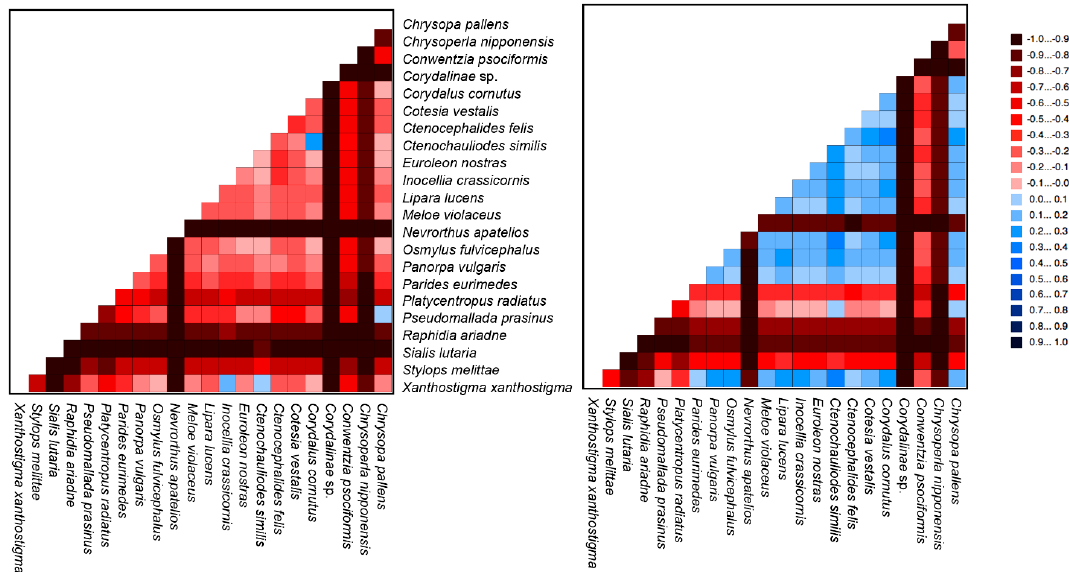
Figure 5. AliGROOVE analysis for nucleotide (NT) and amino acid (AA) sequences. The mean similarity score between sequences is represented by a colored square, based on AliGROOVE scores from -1, indicating great differences in rates from the remainder of the dataset, i.e., heterogeneity (red), to +1, indicating rates match all other comparisons (blue).